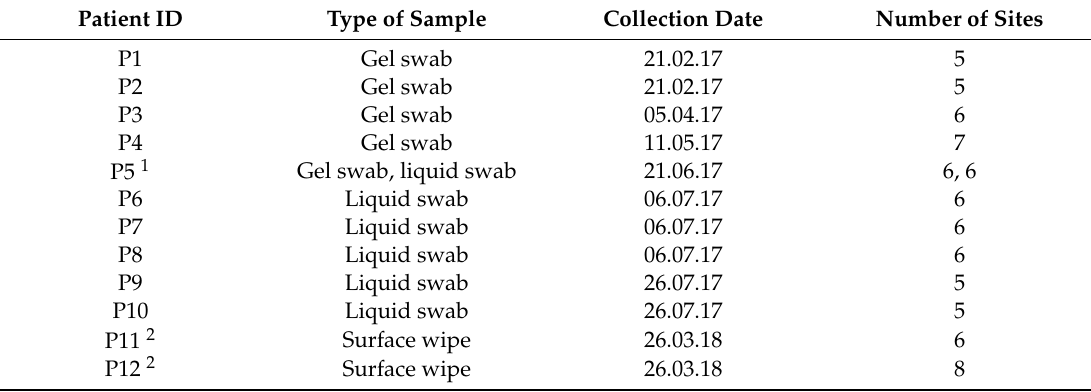
Table 1. Type of sample, collection date, and number of sites analyzed for each patient